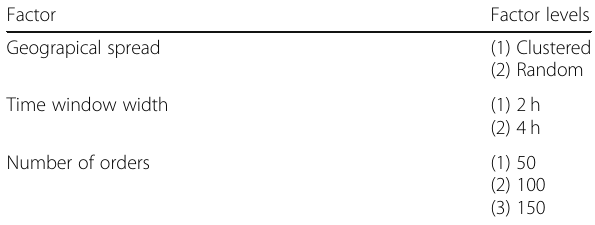
Table 2 Experimental factor setting (design 2: number of orders) Factor Factor levels Geograpical